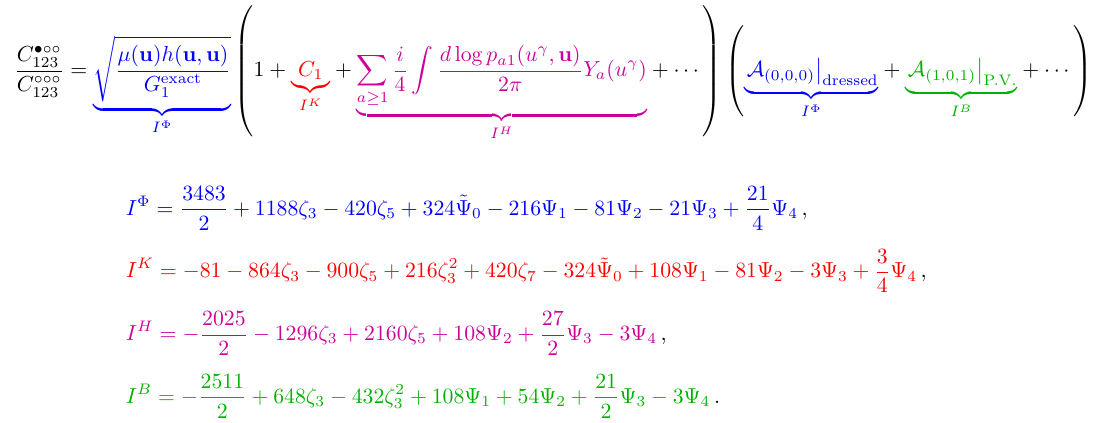
Figure 11 . The regularization of A , together with the wrapping correction to the Gaudin (1 ; 0 ; 1) norm, leads to the \dressed" hexagon series shown at the top. The four loop results for the various contributions are listed above. I (cid:8) comes from the terms proportional to the (cid:12)nite-size correction to the Bethe roots (cid:8) whereas I K denotes the contribution involving the scattering kernel K aa . I H is the term containing the symmetric part of the hexagon form factor and I B is the double integral regularized by the principal-value prescription. Although each contribution contains non- Riemannian transcendental numbers ((cid:9) n ’s in the formulae above), they cancel out if we sum them all, leaving only standard (cid:16) functions. The result after the sum is given by the last line in (5.11), c . For details of the calculation of each term, see appendix (1 ; 0 ; 1)